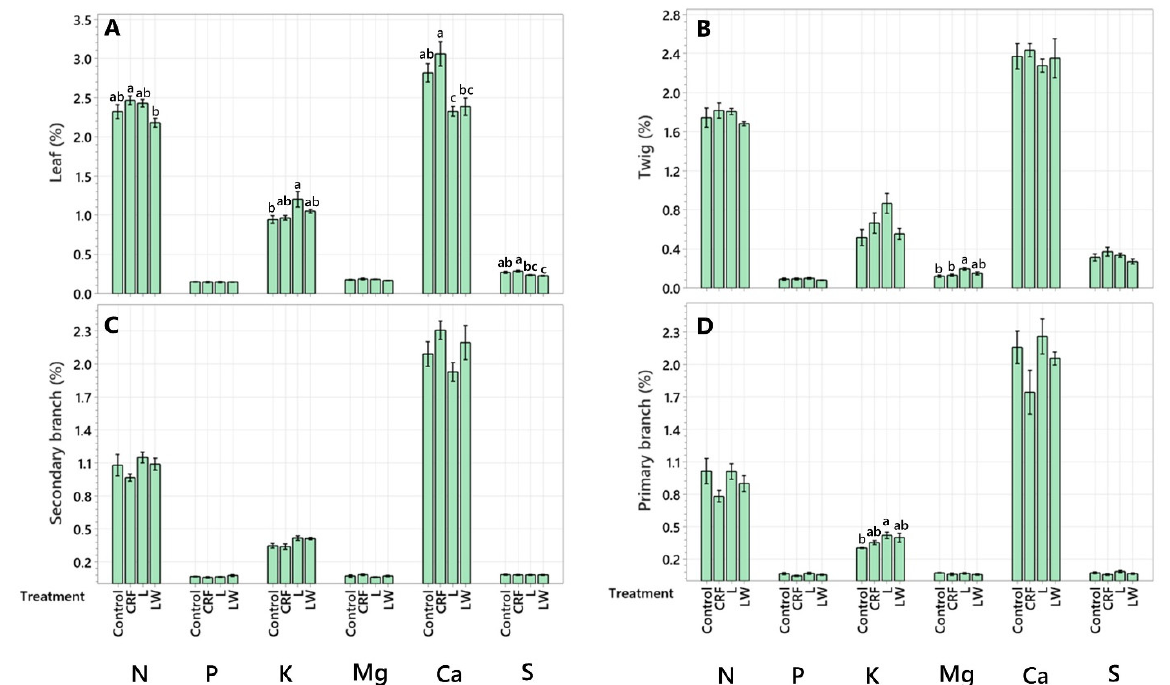
Figure 1. Macronutrient concentration (%) in leaf ( A ), twig ( B ), secondary branch ( C ), and primary branch ( D ). Six-year-old Huanglongbing-affected ‘Ruby Red’ grapefruit trees grafted on sour orange rootstock were used. Treatments consisted of two liquid (L and LW) and two granular fertilizers (Control and controlled-release fertilizer (CRF)). Treatments were applied three times a year (control and CRF), biweekly (L), or weekly (LW), for three years. A one-way variance (ANOVA) with a Tukey’s honestly significant difference (HSD) test was used to determine significant differences between means. Lowercase letters (a, b, c) indicate statistically significant differences ( p ≤ 0.05). Data represents means ( n = 4) ± standard error.